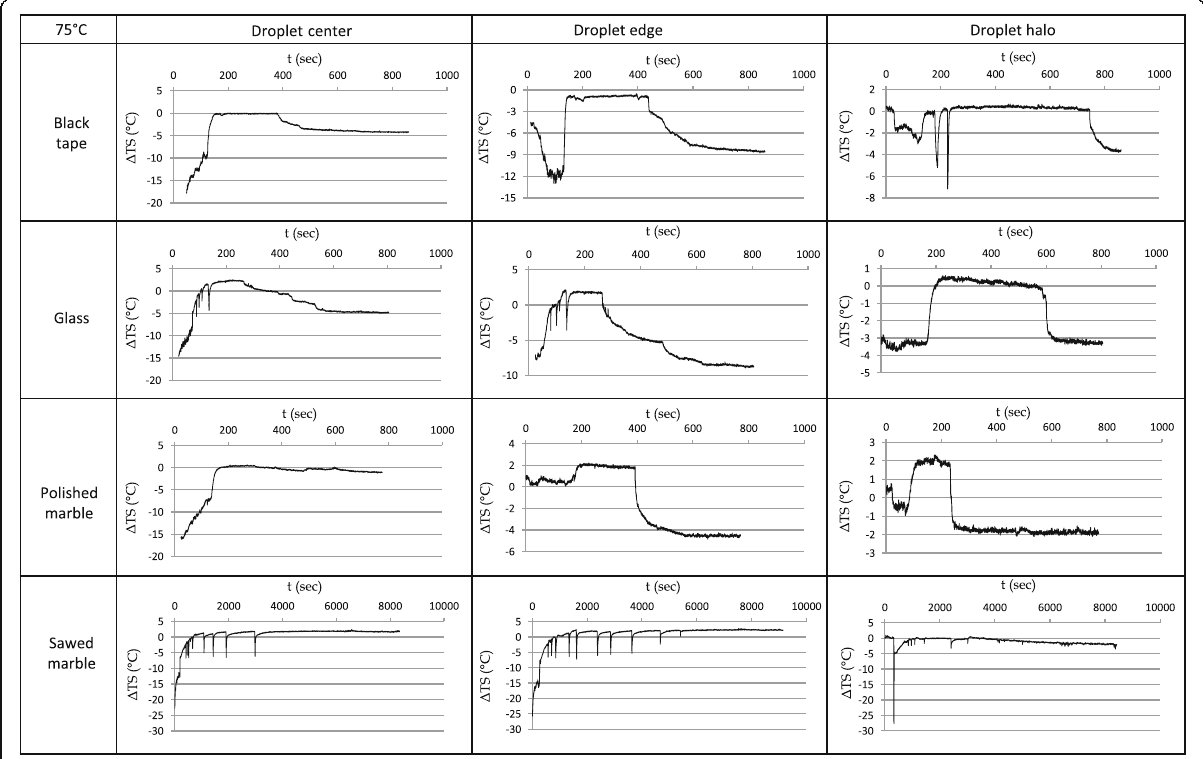
Fig. 7 IRT profiles of each droplet zone at 75 °C for each